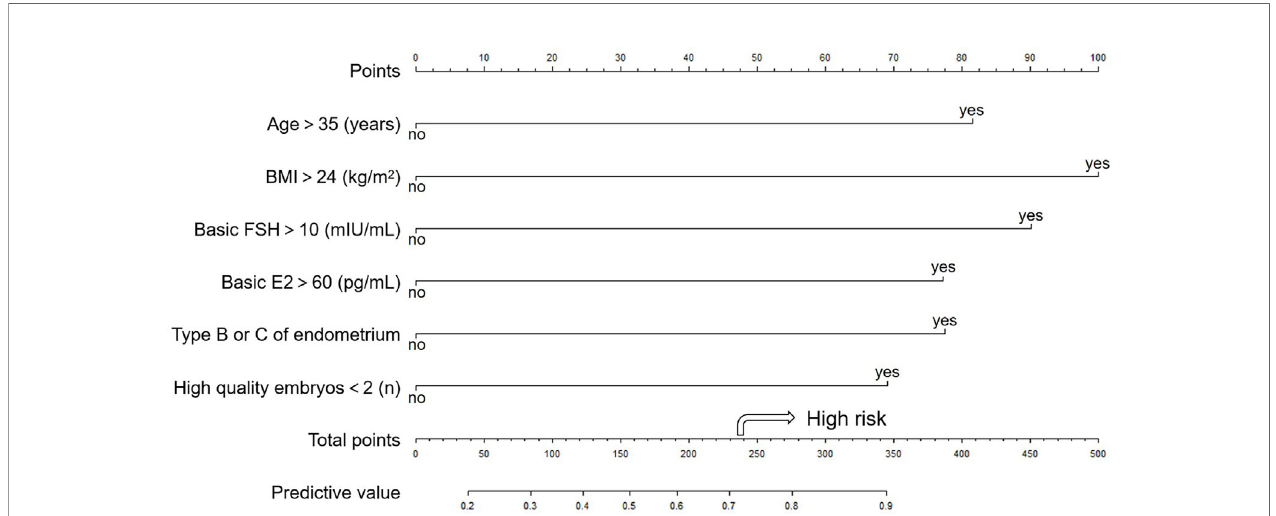
FIGURE 1 | The nomogram to predict the probability of clinical pregnancy failure in PORs. The nomogram can be applied by following procedures: (A) draw a line perpendicular from the corresponding axis of each risk factor until it reaches the top line labeled “ Points ” ; (B) sum up the points for all risk factors and recorded as the total score; and (C) draw a line descending from the axis labeled “ Total points ” until it intercepts the lower line to determine the probability of failed conception. The arrow shows high risk when the total points are greater than 236.472. The optimal threshold point was calculated using receiver operating characteristic (ROC) curve.